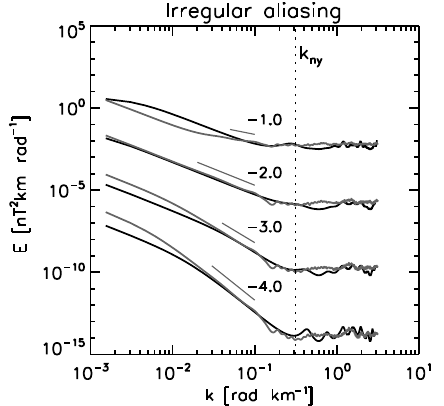
Figure 6. Minimum variance spectra with aliasing for irregular spa- tial samplings ( n = 4 in black and n = 20 in gray) with an irregular distance with a mean 10km with 30%